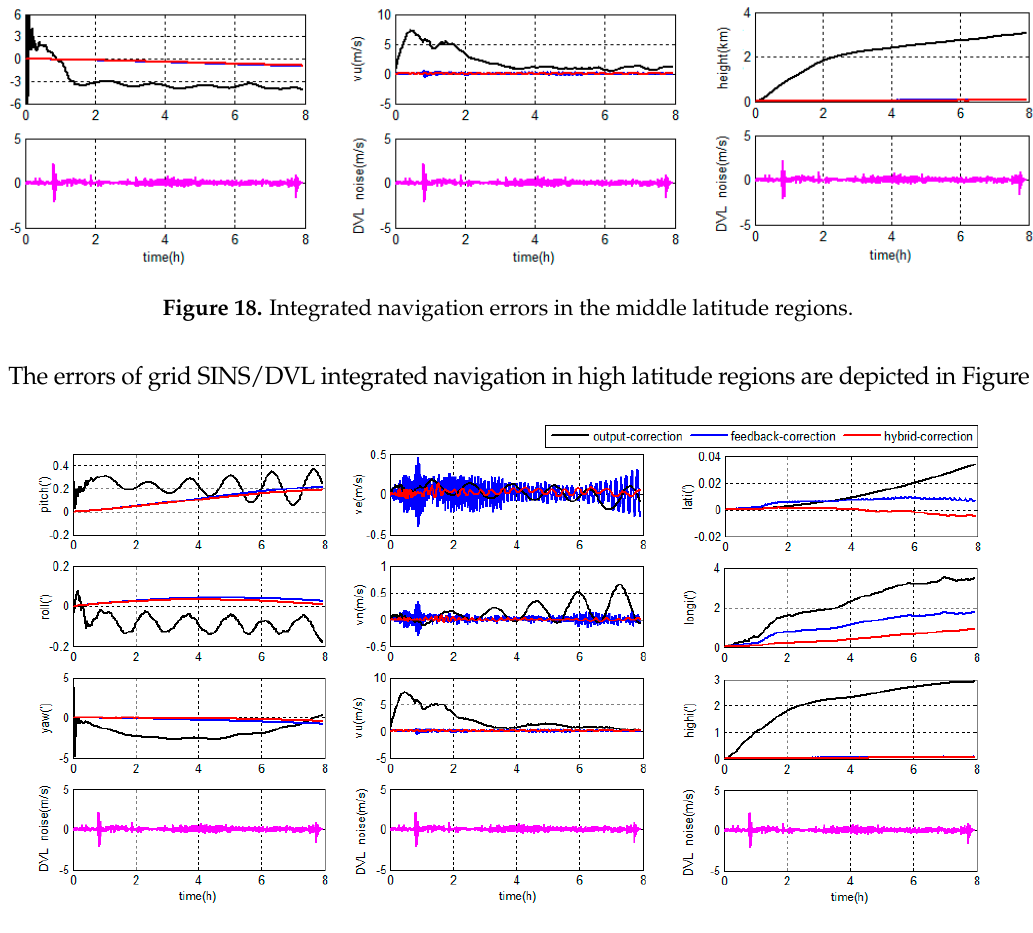
Figure 19. Integrated navigation errors in the high latitude regions.